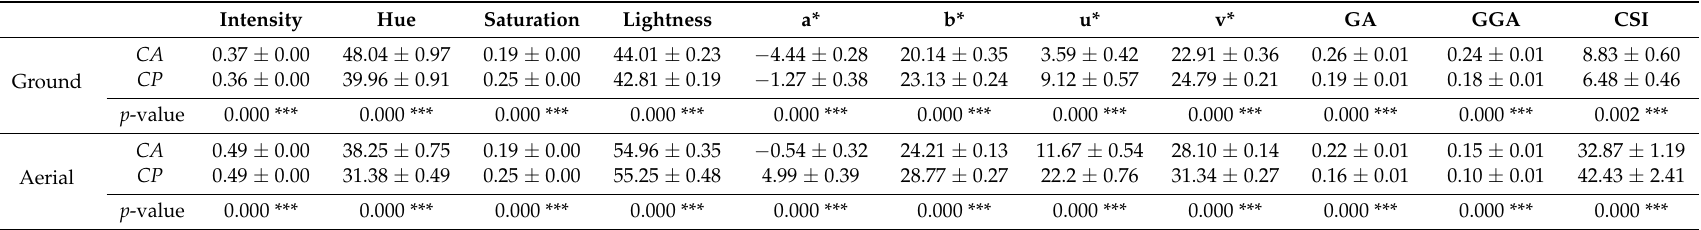
Table 4. Effect of tillage practices and placement of the sensors (ground versus aerial) on the RGB indexes. These indices are defined in Materials and Methods. Values are means ± standard error. Level of significance ( p -value): ***, p < 0.001. Treatments: CA, conservation agriculture; CP, conventional agriculture.